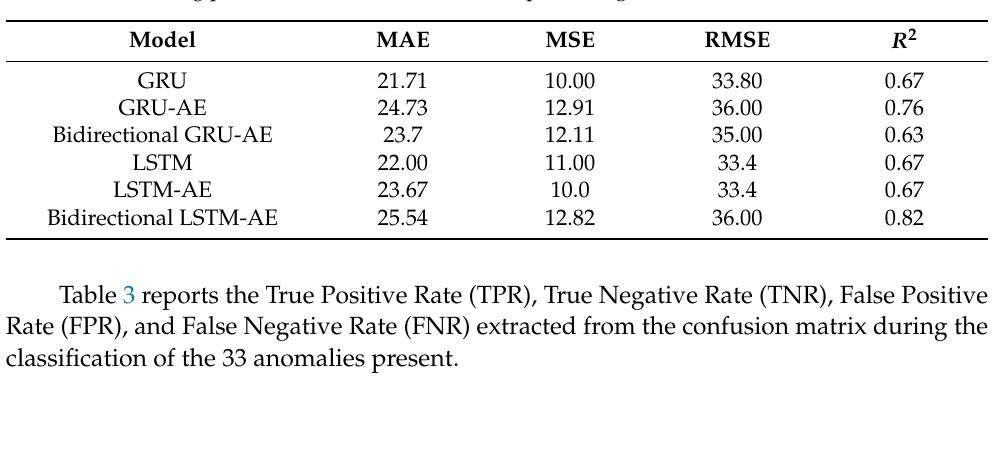
Table 2. Forecasting performance metrics for the deep learning